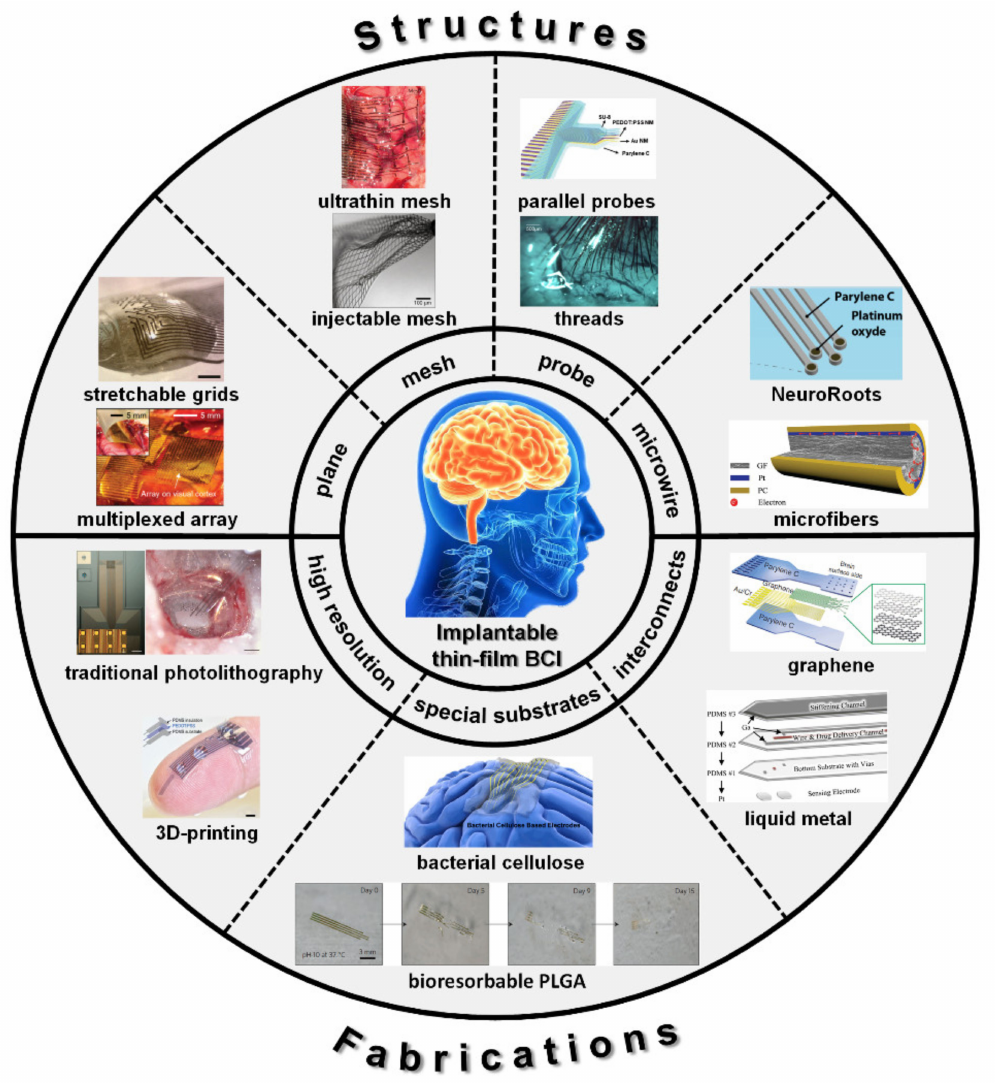
Figure 1. Classification of implantable thin film devices as Brain-computer interface (BCI) according to the four structure layouts and three fabrication approaches (reprinted with permissions from